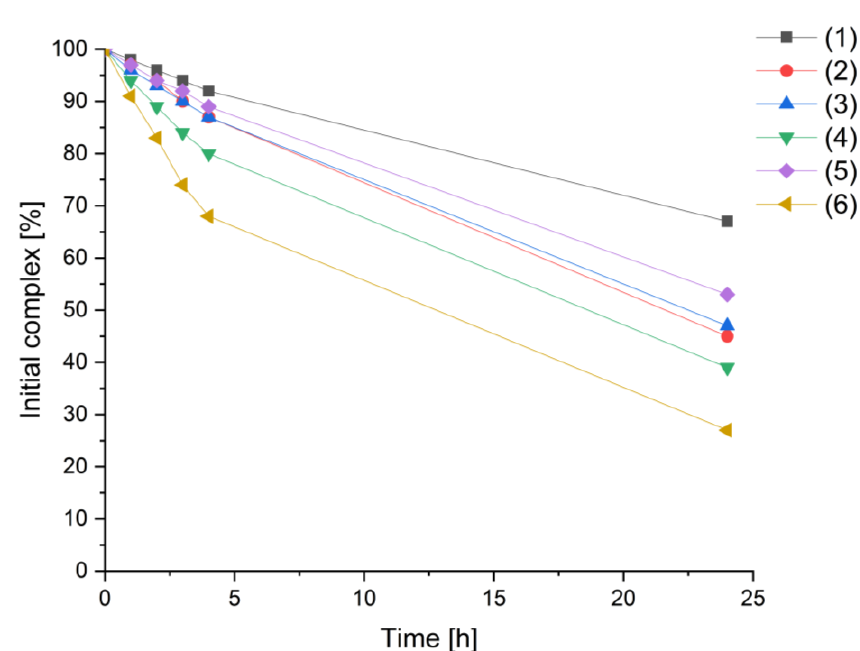
Figure 4. The percentage amount of initial complex vs. time in PBS (pH = 7.4) at 20 °C. The complex signals were detected between 12.1 – 15.9 min with the